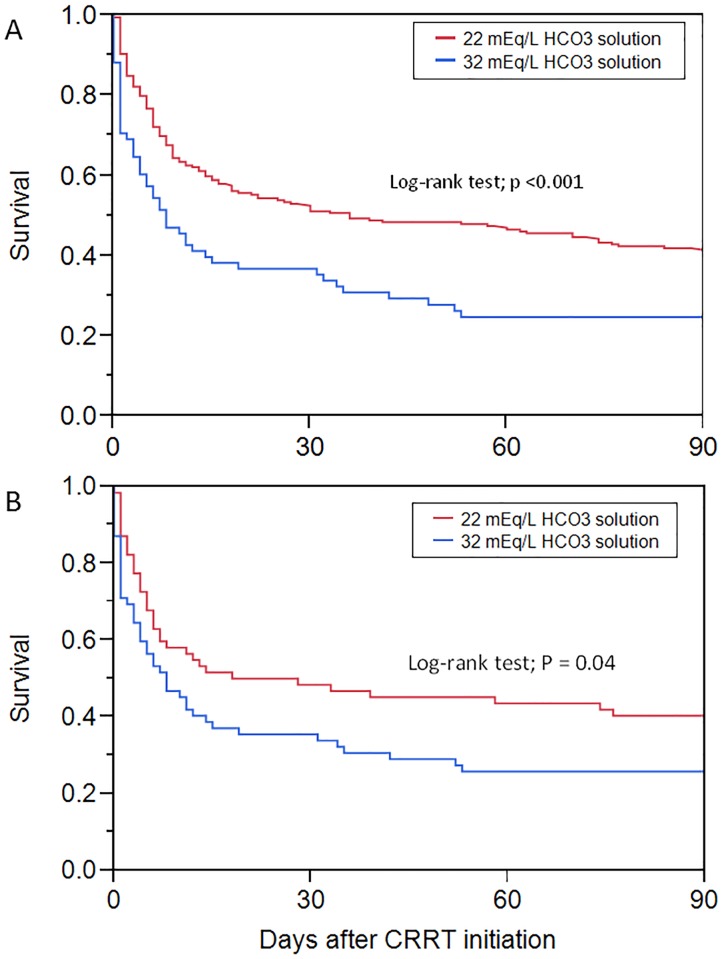
Kaplan-Meier plot is demonstrating survival in 32mEq/L vs. 22mEq/L HCO3 solution groups.A) Full cohort adjusted for ICU type, pH, HCO3, K, and phosphorus. The Hazard Ratio is 1.76 (95% CI, 1.26–2.42; P<.001) and the Adjusted Hazard Ratio* was 1.50 (95% CI, 1.03–2.14; P = .03). B) Propensity-matched cohort with a Hazard Ratio of 1.55 (95% CI, 1.01–2.41; P = .04). *adjusted for ICU type, pH, HCO3, K, and phosphorus. Abbreviations: HCO3, Bicarbonate; ICU, Intensive Care Unit; K, Potassium.